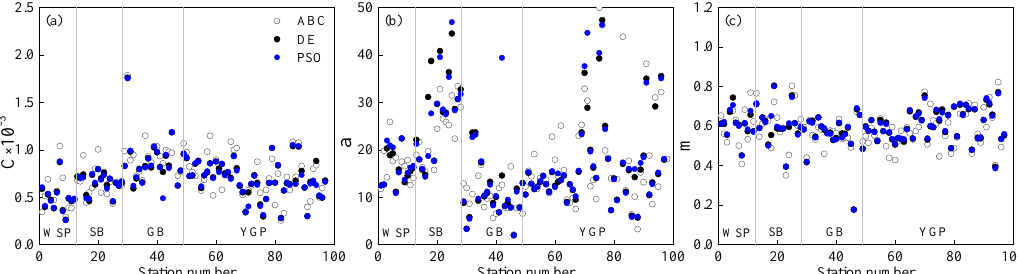
Figure 3. ( a – c ) Calibration results of HG model empirical parameter ( C , a , m ) based on the ABC, DE and PSO optimization methods. Note, NSP: Northwest Sichuan Plateau; SB: Guangxi Basin; GB: Sichuan Basin; YGP: Yunnan–Guizhou Plateau.